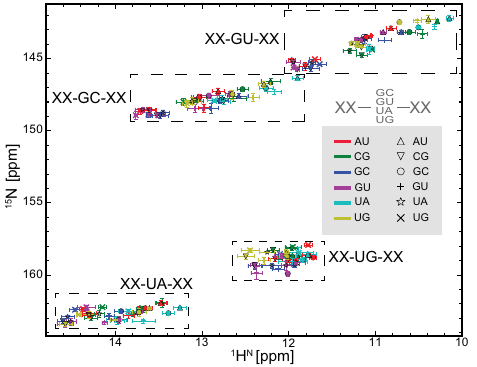
Fig. 2 Imino chemical shift map of BP-triplets. The average imino resonance of each BP-triplet is shown as a marker on the map. Each BP- triplet can be described as a triplet code (see Fig. 1a): the dashed boxes depict the chemical shift distribution range of the central guanine or uridine residue as de fi ned by the fi rst letter of the middle code; the 5 ′ and 3 ′ neighboring base pairs are de fi ned by color and shape of makers, respectively. The error bars indicate one standard deviation (s.d.; the corresponding sample sizes are provided in Supplementary Table 2).